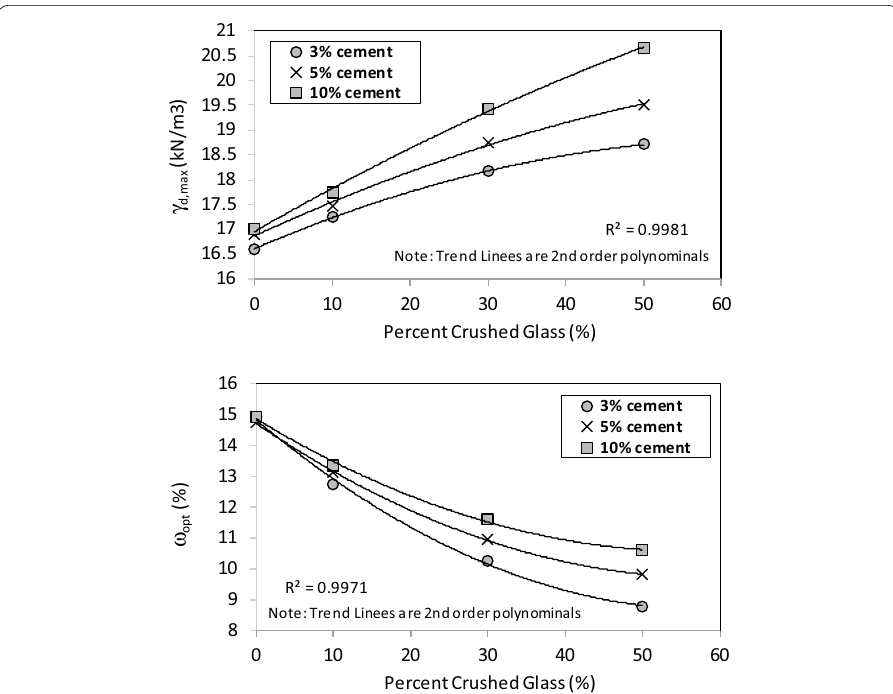
Fig. 3 Line of optimums for cement stabilized SM and CG–SM